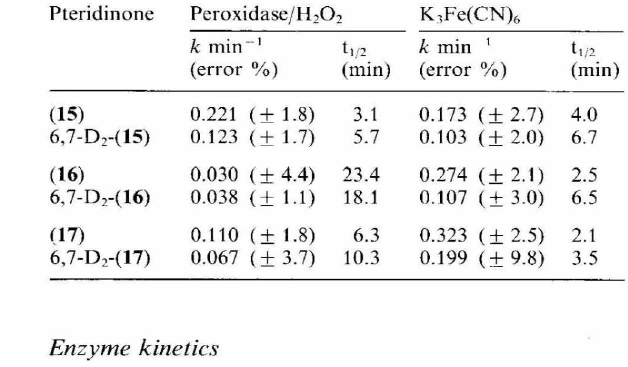
Table 1. First order rate constants and half lives of the pteri dinones (15), (16) and (17) and their 6,7-dideuterio derivatives after oxidation (/1."naIYI 300 11m, pH 7.3 and 25 DC)